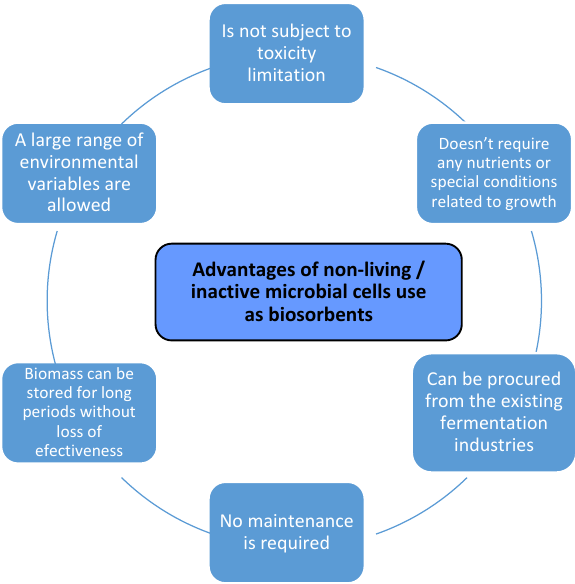
Figure 1. Advantages of using metabolically inactive microbial biomass.